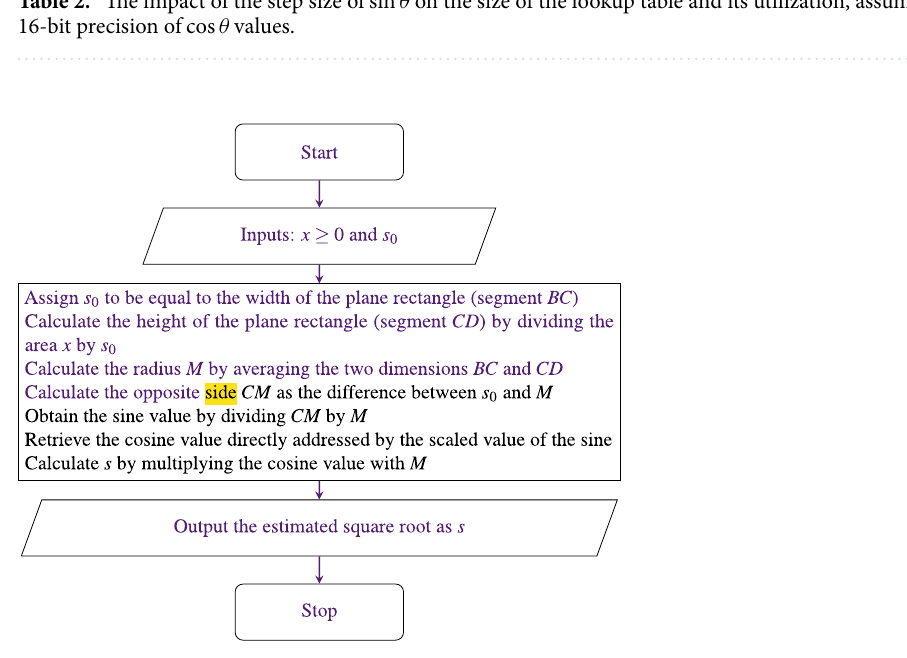
Figure 5. Flowchart of our proposed algorithm to compute the square root of an unsigned number x